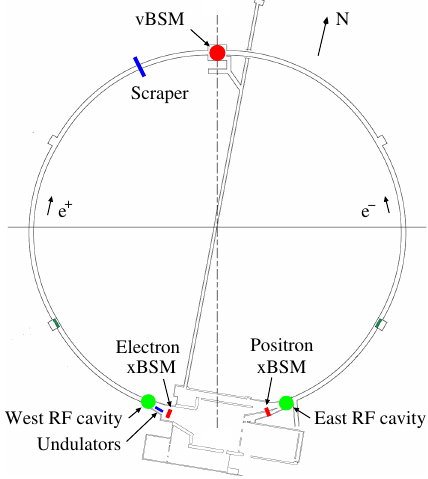
FIG. 1. CESR layout showing the locations of rf cavities, undulators, scrapers, x-ray beam size monitors (xBSM) and visible-light beam size monitor